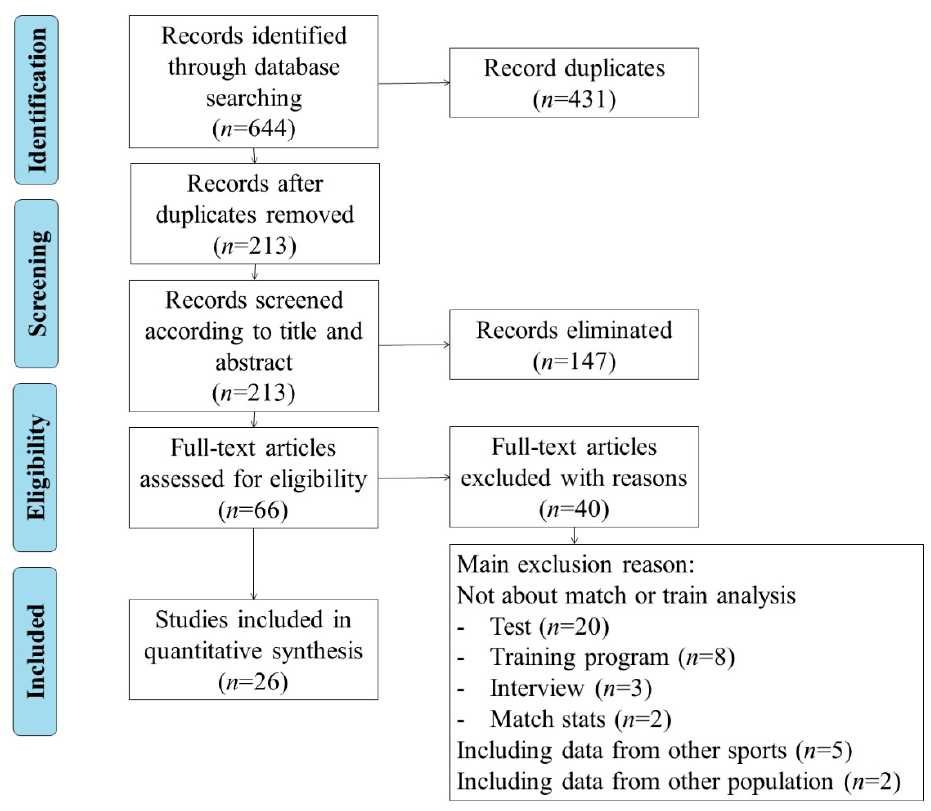
Figure 2. Flow Figure 2. Flow chart.